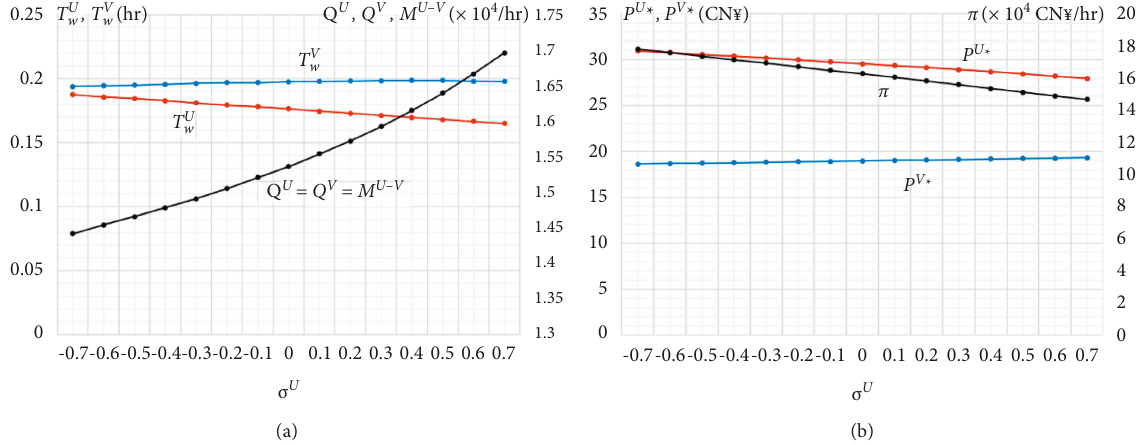
Figure 4: Sensitivity analysis with respect to passengers’ correlation coefficient. (a) Changes in T U P U ∗ , P V ∗ , and π .